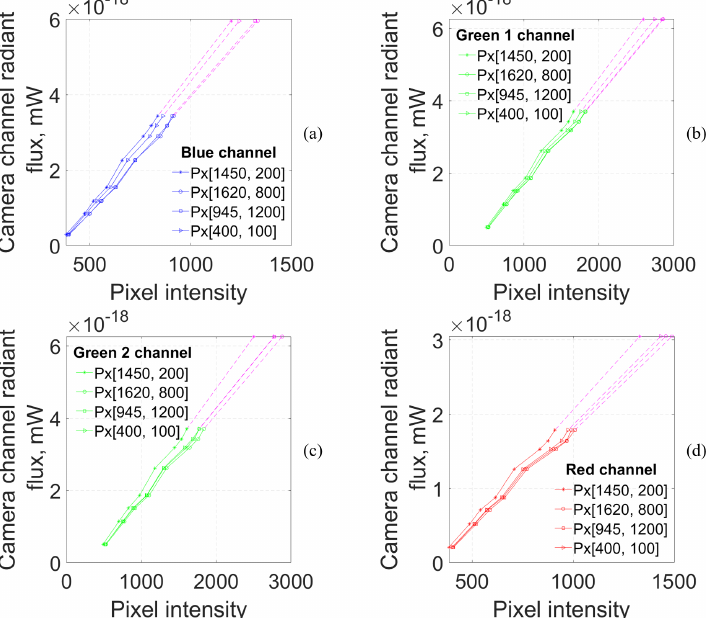
Figure 5. Examplary calibration curves for the blue ( a ), green 1 ( b ), green 2 ( c ), and red ( d ) camera pixels [1450, 200], [1620, 800], [945, 1200], and [400, 100] (counted after image debayerization) for a microscope objective Nikon Plan: 40 × /0.65, ∞ /0.17, WD 0.56 (LED current: 4500 mA, ILCX: − 106 µ m, ILCY: − 201 µ m).